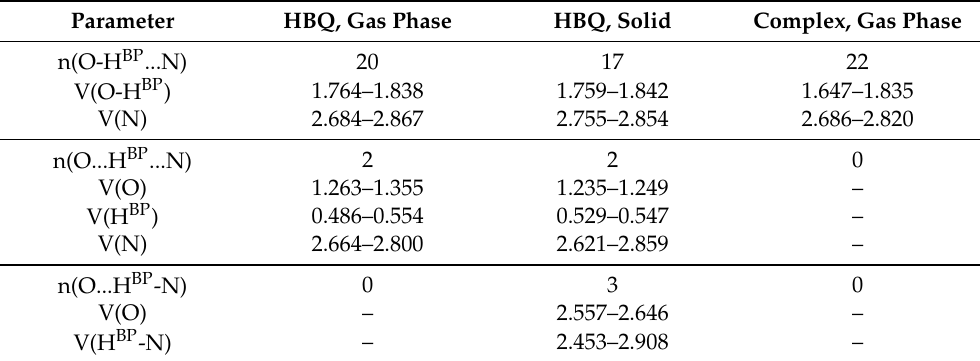
Table 2. Populations (minimum–maximum) of the ELF basins related to the O-H...N hydrogen bridges in HBQ (gas phase and solid) and the benzo[h]quinoline-2-methylresorcinol complex (gas phase). The first row for each of the three bridge structures show the number of reported cases from among 22 snapshots. The possible structures are, from top to bottom respectively, the proton at the donor side, a proton in the middle, and proton at the acceptor